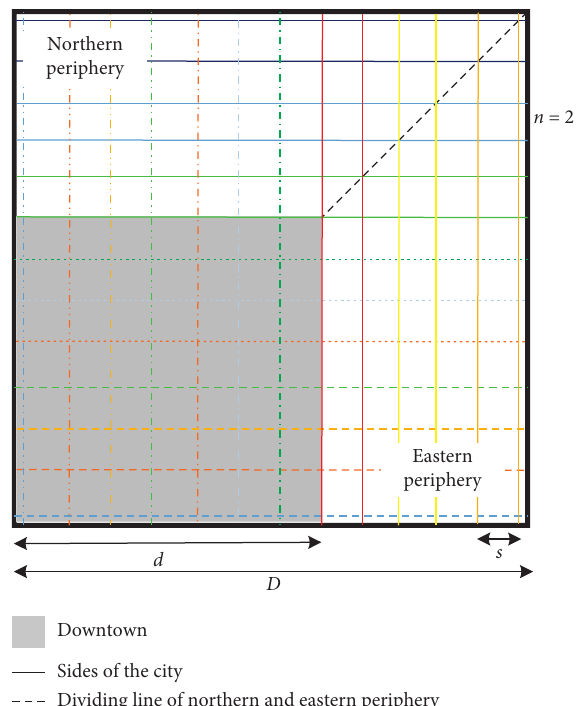
Figure 1: The sparse and dense mixed grid model. ∗ Lines of the same line type and color are run by the same